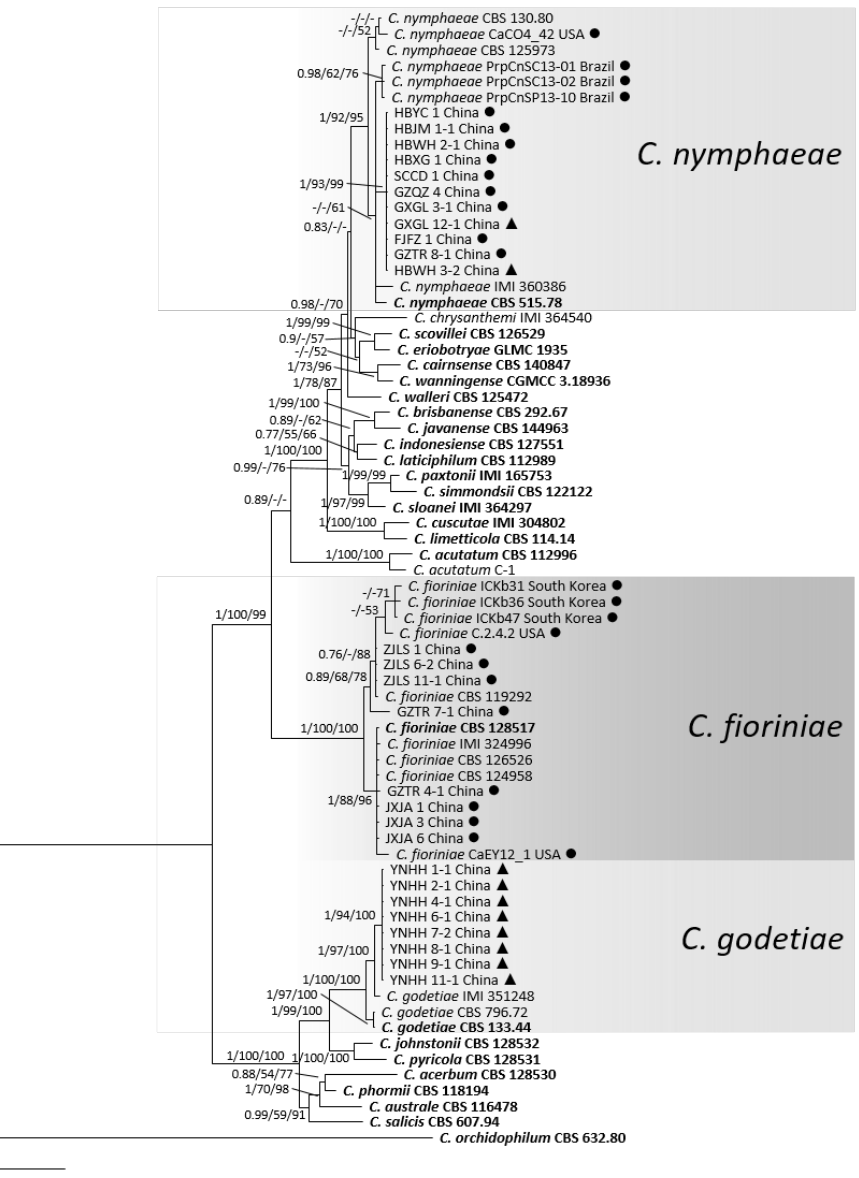
Figure 3. A Bayesian inference phylogenetic tree of 71 isolates in the C. acutatum species complex. C. orchidophilum (CBS 632.80) was used as the outgroup. The tree was built using combined sequences of the ITS, GAPDH , CHS-1 , HIS3 , ACT , and TUB2 . BI posterior probability values (BI ≥ 0.70), MP bootstrap support values (MP ≥ 50%), and RAxML bootstrap support values (ML ≥ 50%) were shown at the nodes (BI/MP/ML). Tree length = 827, CI = 0.71, RI = 0.93, RC = 0.65, HI = 0.30. Ex-type isolates are in bold. Circles indicate isolates from fruits, and triangles indicate isolates from